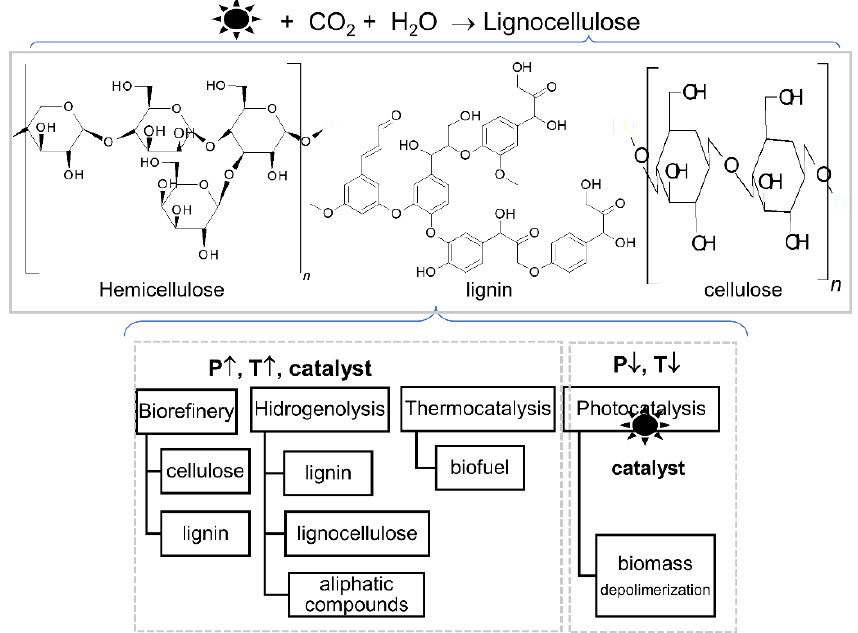
Figure 3. Routes for the recovery of lignocellulosic biomass [10]. Adapted with permission from Nature/Springer/Palgrave, Nature Catalysis , Solar energy-driven lignin-first approach to full utilization of lignocellulosic biomass under mild conditions, Xuejiao W. et al., License Number: 5382740520618, 2018.